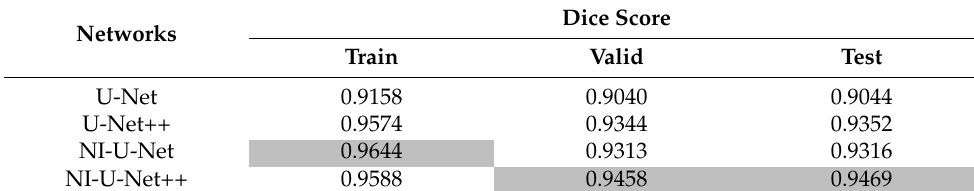
Figure A3. The pairwise comparisons for U-Net, U-Net++, NI-U-Net, and proposed NI-U-Net++. Table A2. The Dice score of U-Net, U-Net++, NI-U-Net, and NI-U-Net++.